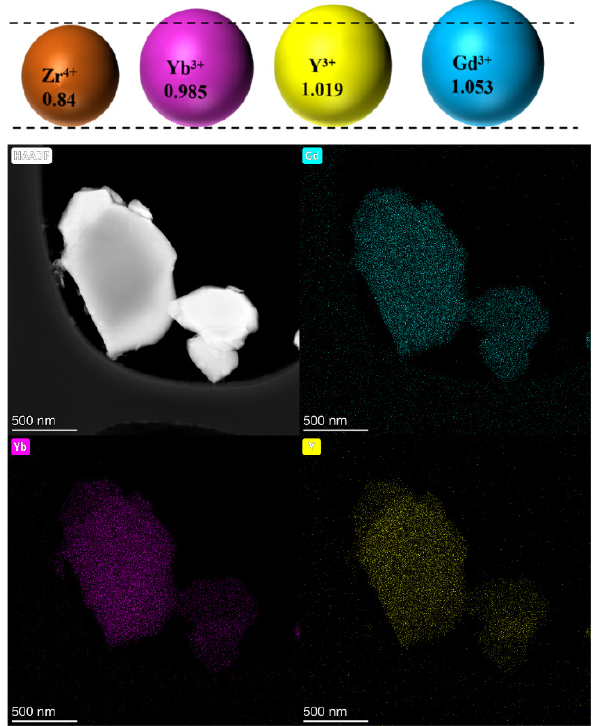
Figure 5. Elemental distribution of the 2Gd-4Yb-4Y powder after heat treatment for 150 h at 1300 °C.